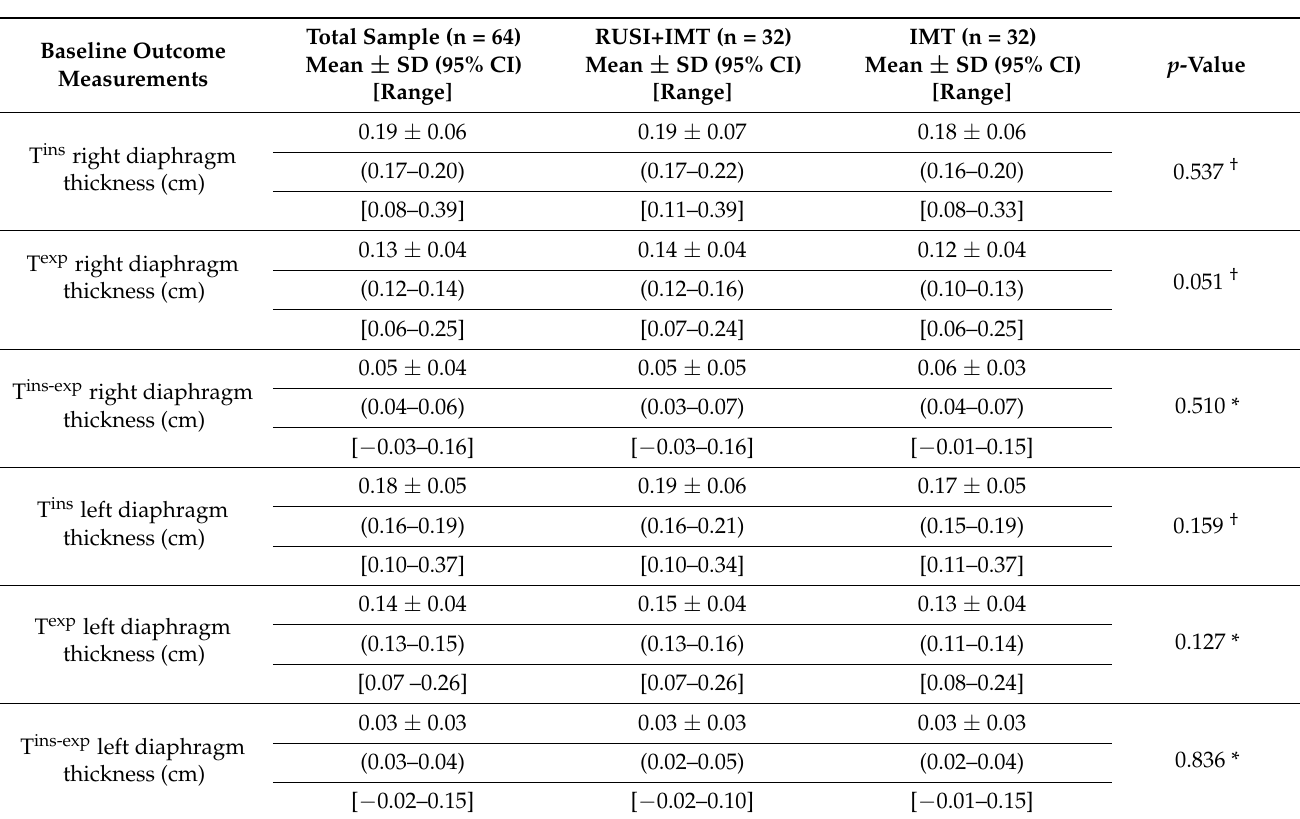
Table 2. Baseline outcome measurements for the total sample and their comparison for RUSI+IMT and IMT